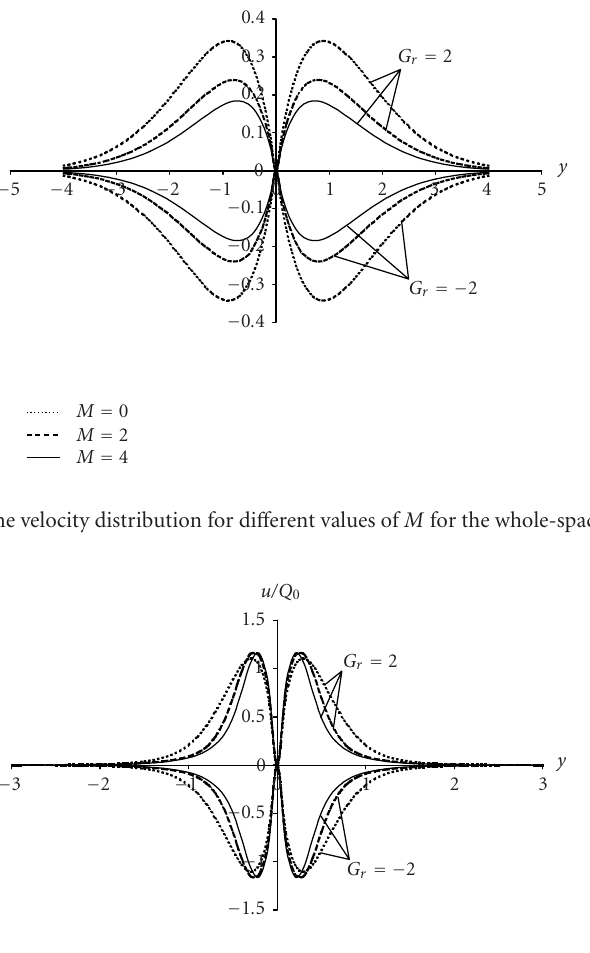
(ii) In Figures 7.3, 7.4, 7.5, and 7.6 and Figures 7.8 and 7.9, we observe that the e ff ect of cooling and heating by free convection currents occurs when G r > 0 and G r < 0 are in agreement with physical observations that cooling of the surface by free convection currents occurs for positive values of G r while heating corresponds to negative values of G r . It was also noticed that the velocity and angular velocity increase with the increase of G r